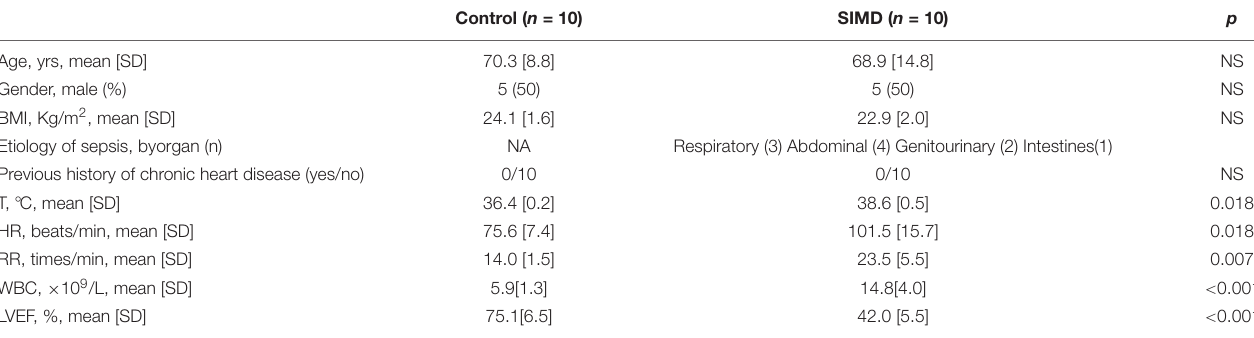
TABLE 1 | Characteristics of control and SIMD patients.